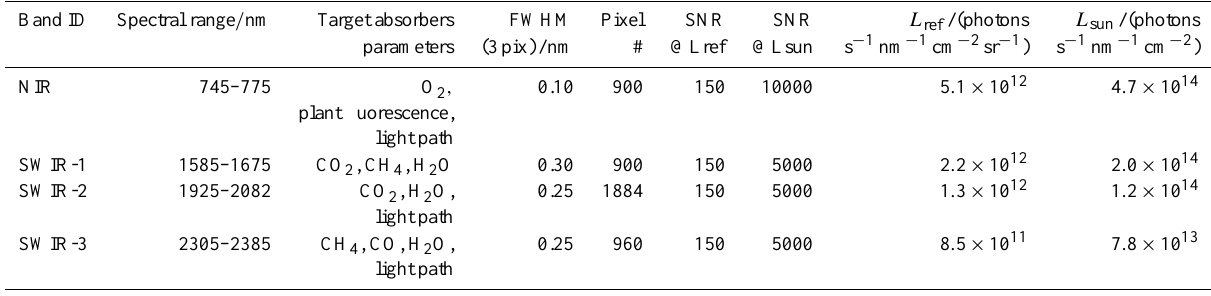
Table 1. Spectroscopic properties of the G3E spectrometer system. Spectral resolution is given in terms of full width half maximum (FWHM) of the instrument spectral response function (ISRF) under the assumption that the given width is sampled by 3 detector pixels. Signal-to-noise (SNR) requirements are listed for the expected solar irradiance ( L sun ) and a backscattered radiance ( L ref ) corresponding to a relatively dark reference scene (albedo = 0.1, SZA = 70 ◦ ).